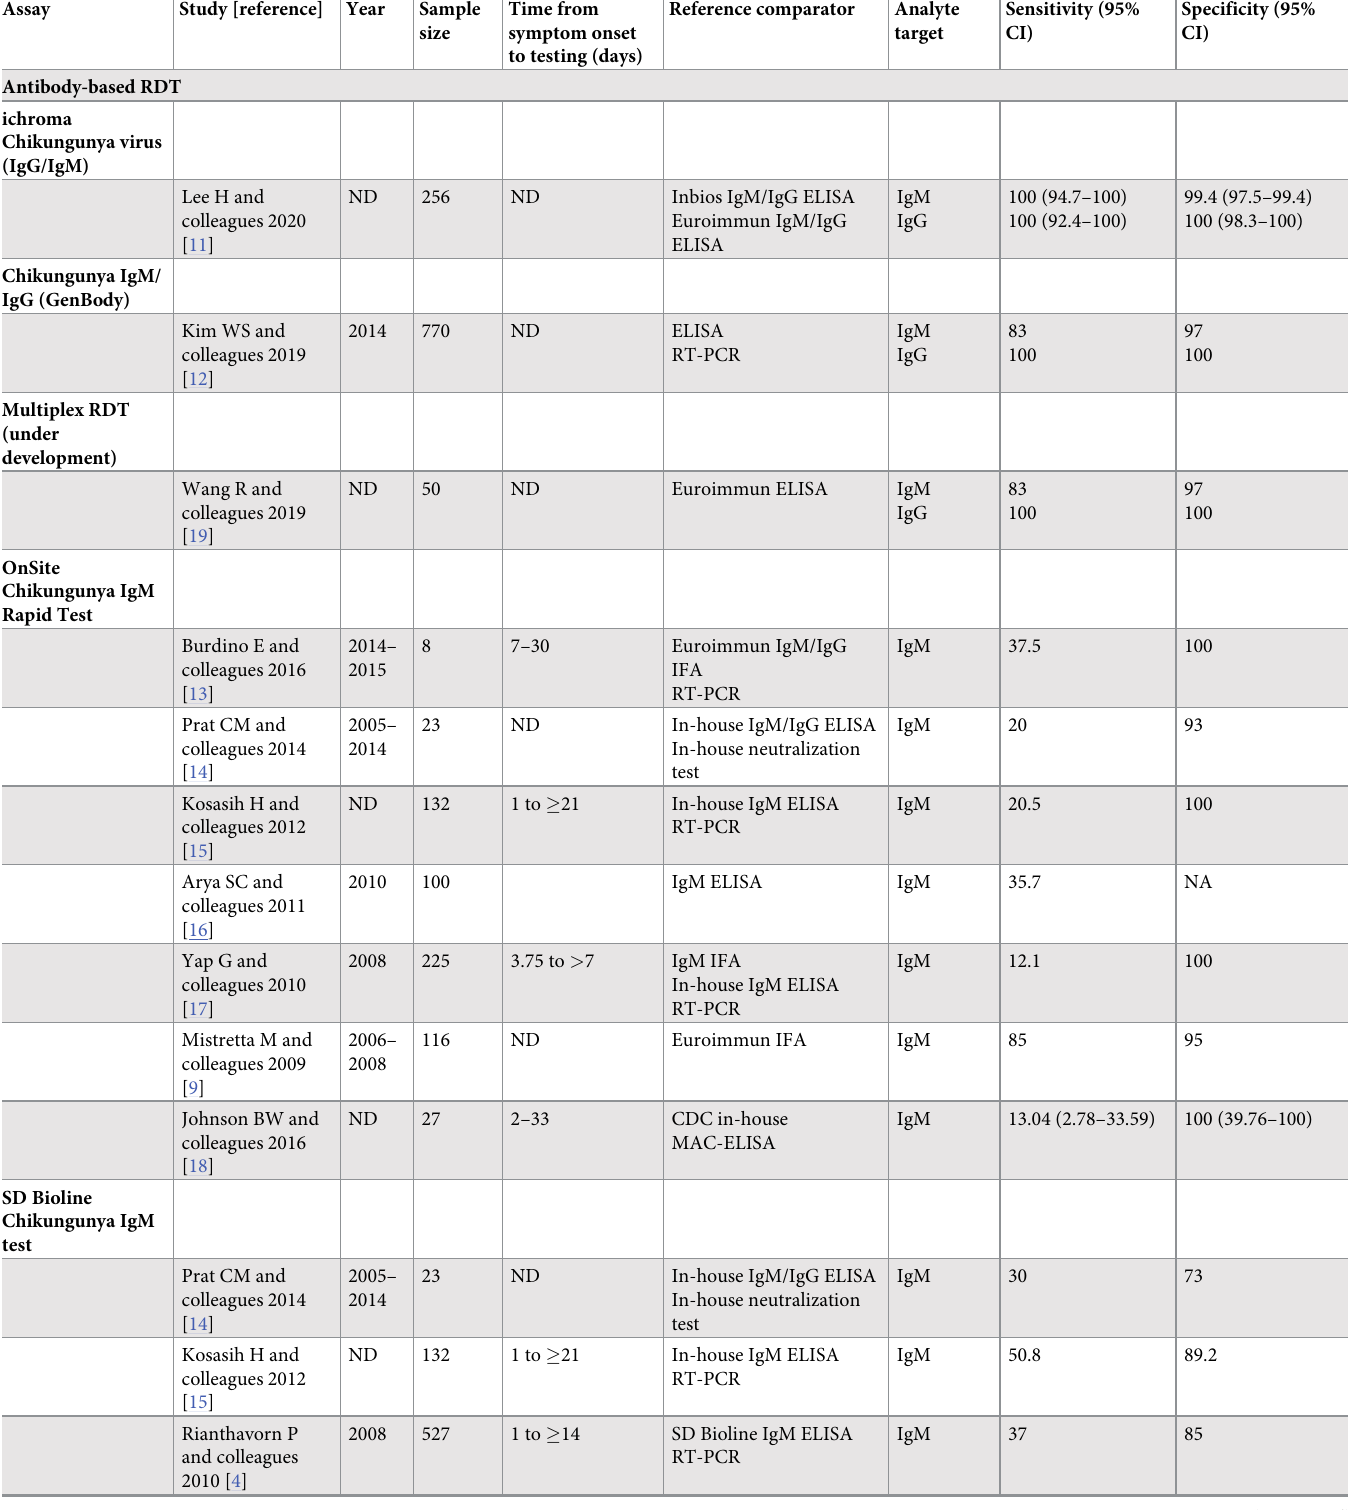
Table 3. Summary of diagnostic assessments of Chikungunya antibody or antigen-based rapid diagnostic tests, 2005–2018.